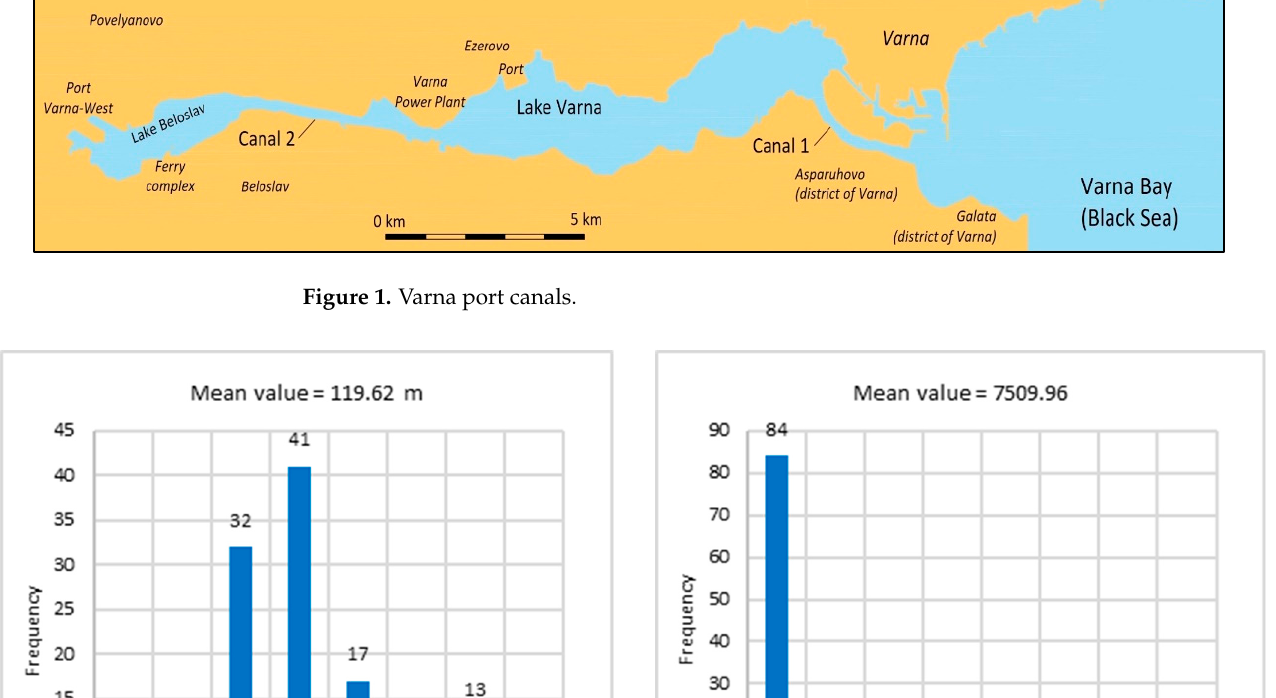
Figure 1. Varna port canals.